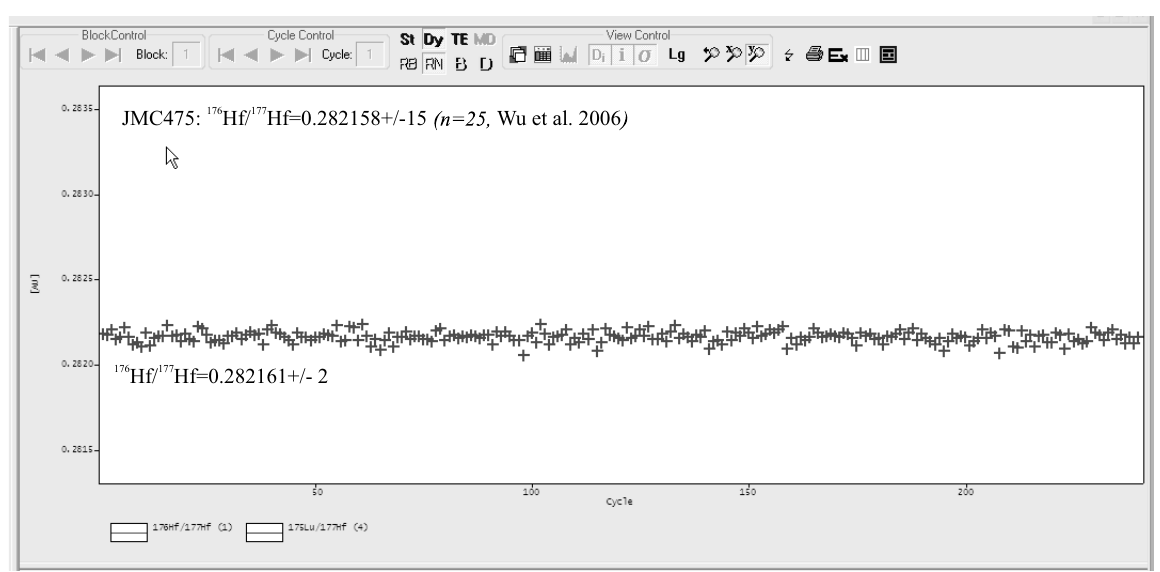
Fig. 1 – Typical analyses of JMC475 standard solution (6 blocks of 40 cycles of 4.034 seconds each). Mean value for JMC475 reported in literature and result of analysis are shown.